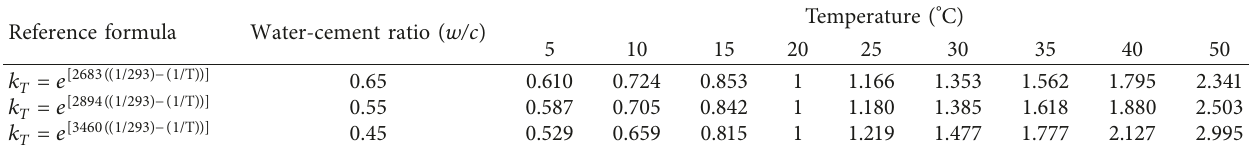
Table 4: Values of k T at different